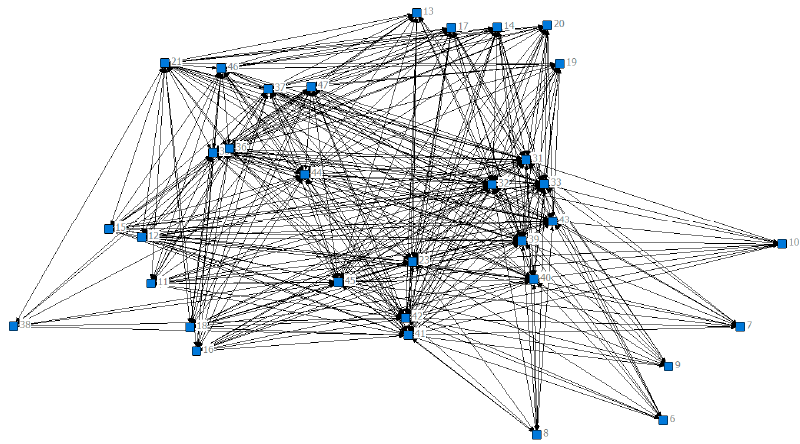
Figure 2. Weighted network diagram of air transportation.